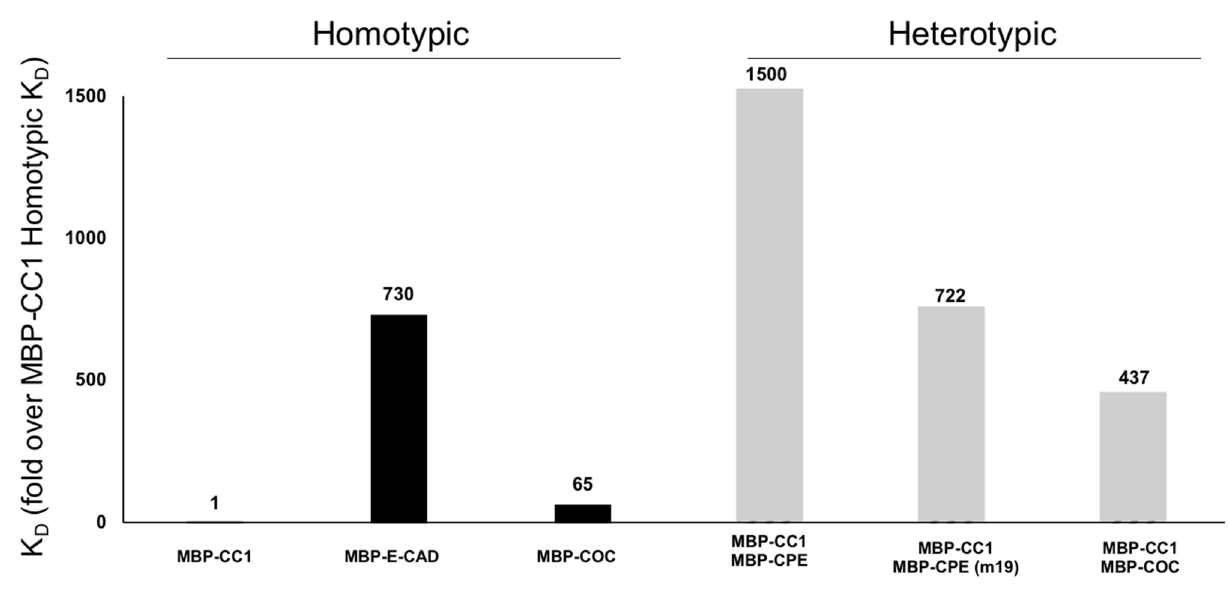
Figure 2. Surface Plasmon Resonance (SPR) of MBP-CC1. The constant of affinity (K D ) of several proteins associated with the TJ were determined by SPR. Using MBP-CC1 homotypic interaction as a control, we normalized the K D of the other interactions. Homotypic interactions of MBP-CC1, MBP-eCAD (AJ), and MBP-COC. These results suggest that CLDN1 interactions are 700-times stronger than MBP-eCAD or 65-times stronger than MBP-COC. We followed this analysis with heterotypic interactions of MBP-CC1 with MBP-CPE and MBP-CPE(m19) mutant or the interactions between MBP-CC1 and MBP-COC.